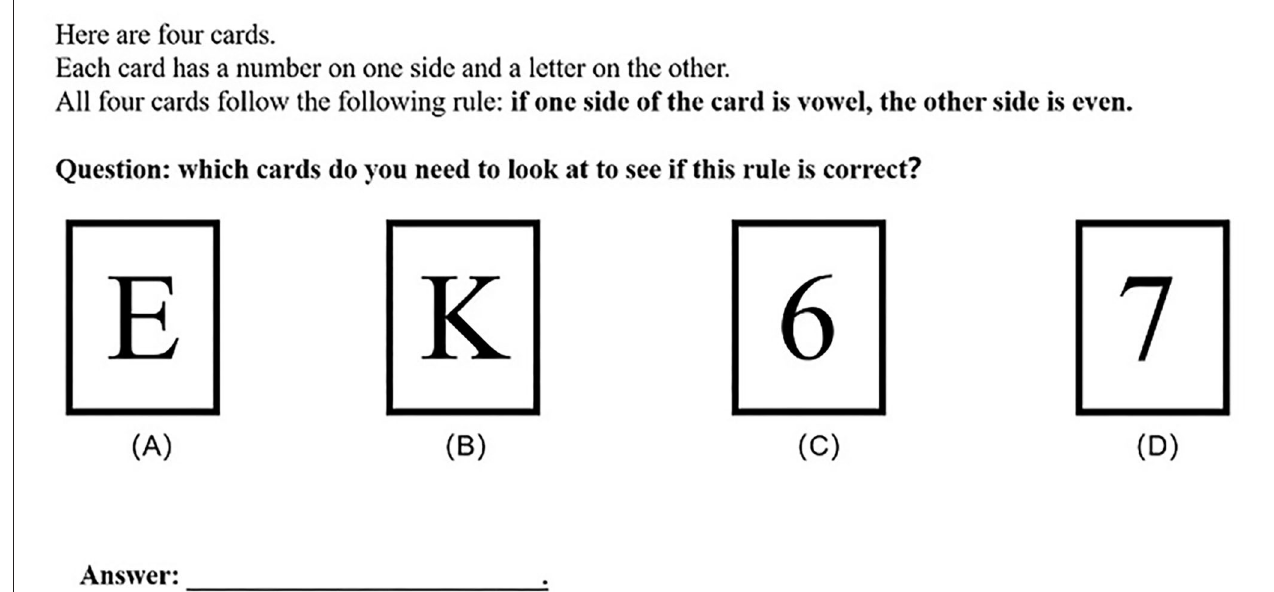
FIGURE 1 | Illustration of the classical Wason’s selection task in this